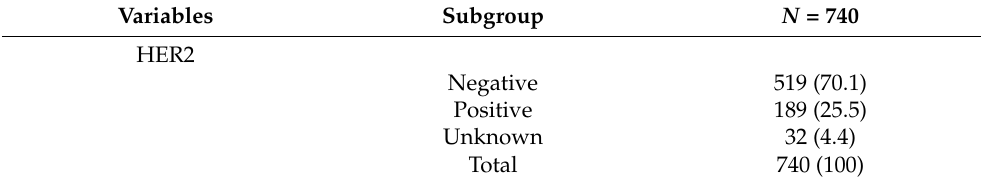
Table 1. Cont. Variables Subgroup HER2 519 (70.1) 189 (25.5) 32 (4.4) Total 740 (100) Categorical values were described as a “number (%)” Continuous values with an asterisk (*) were described as the “mean ± standard deviation(minimum-maximum)”. T, tumor size; N, axillary lymph node; ER, estrogen receptor; PR, progesterone receptor; HER2, human epidermal growth factor receptor 2.